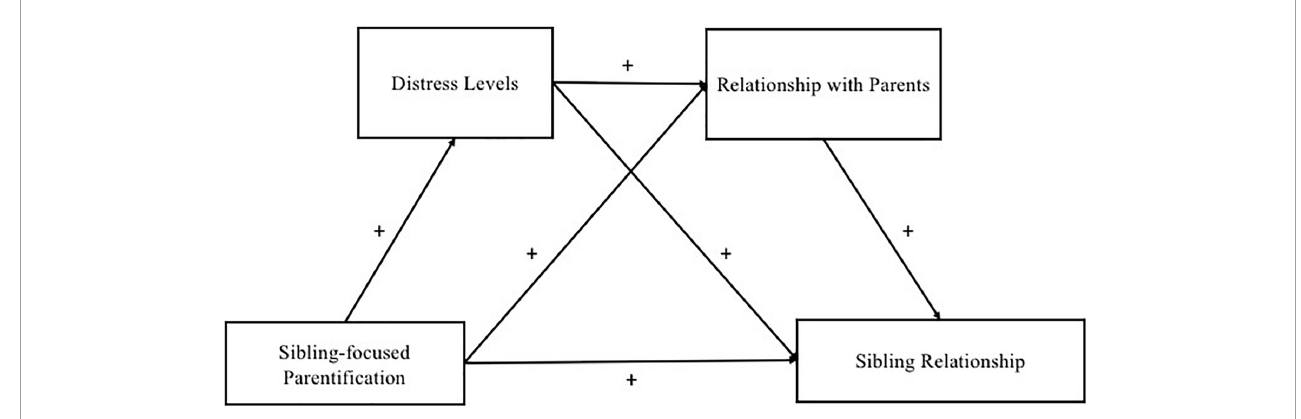
FIGURE1 The hypothesized serial mediation